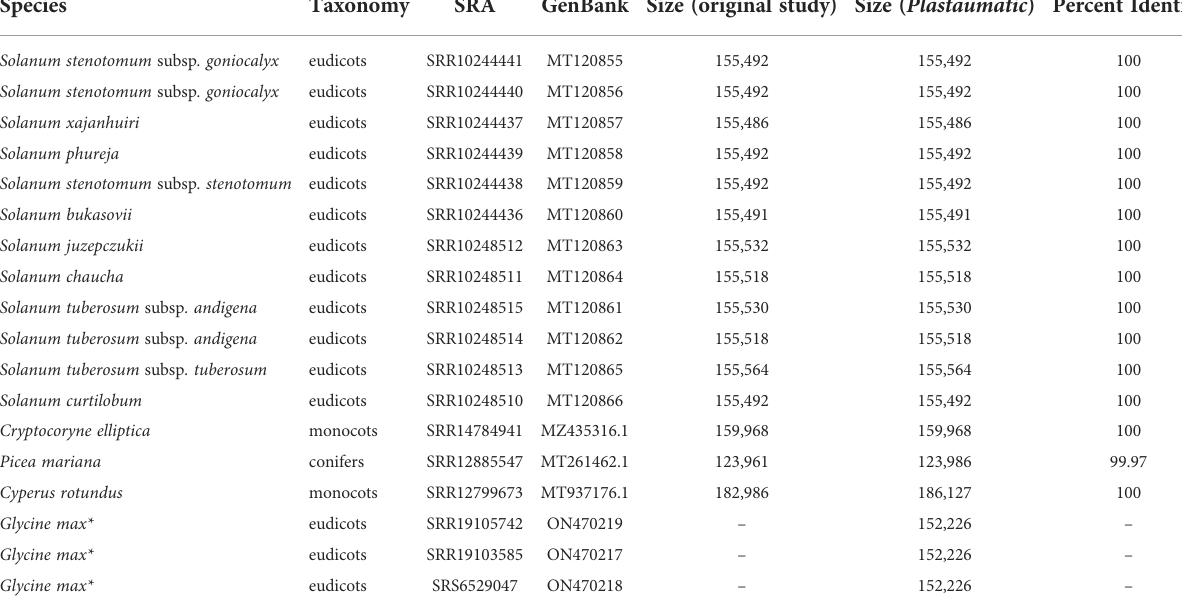
TABLE 2 List of species used in testing the